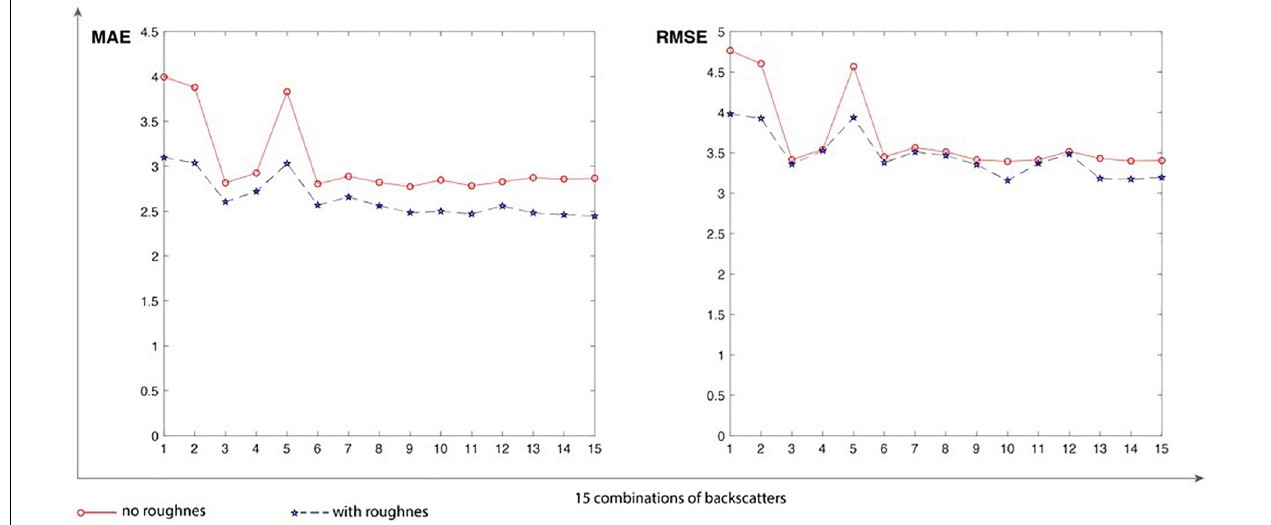
FIGURE 6 | Comparison of cross-validation results of backscatter-BSSM and backscatter-roughness-BSSM models analyzed by parametric regression in low-dimensional space.